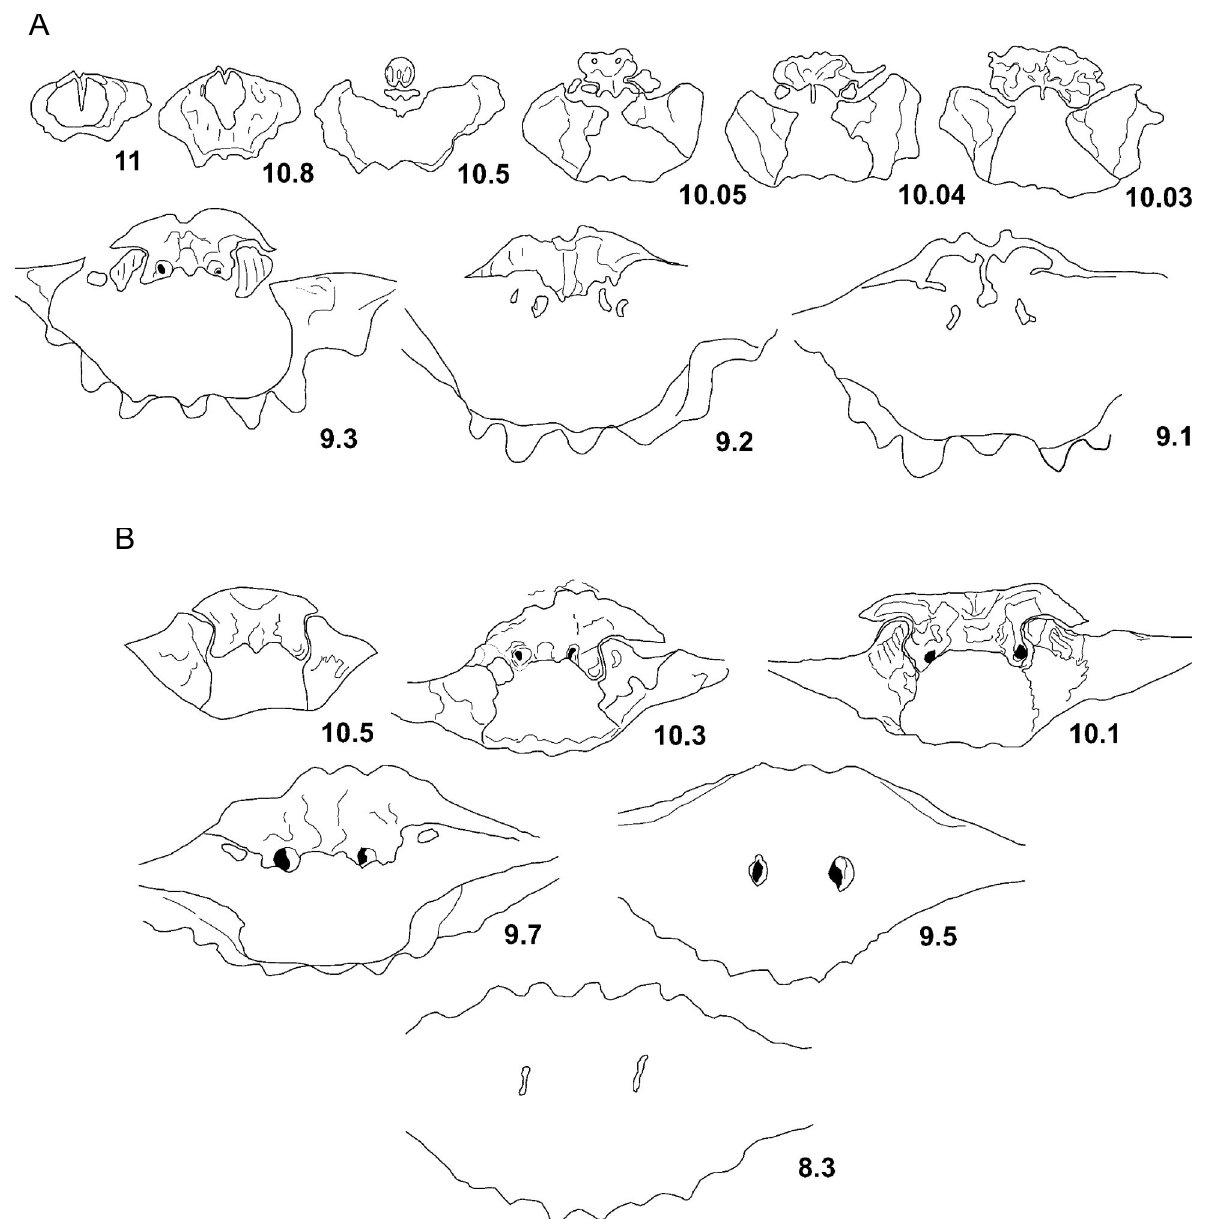
Fig. 8. Transverse serial sections of Stegocornu procerum D(cid:252)rkoop, 1970; Llandovery, mid-late Aeronian, Niur Formation, sample K25, Boghu Mountains; A , CNIGR 12600/128 (L = 11.2, W = 13.6, T = 8.4); B , CNIGR 12600/129 (L = 10.7, W = 15.4, T = 10.5). Numbers indicate distances (mm) from the apex of the shell.